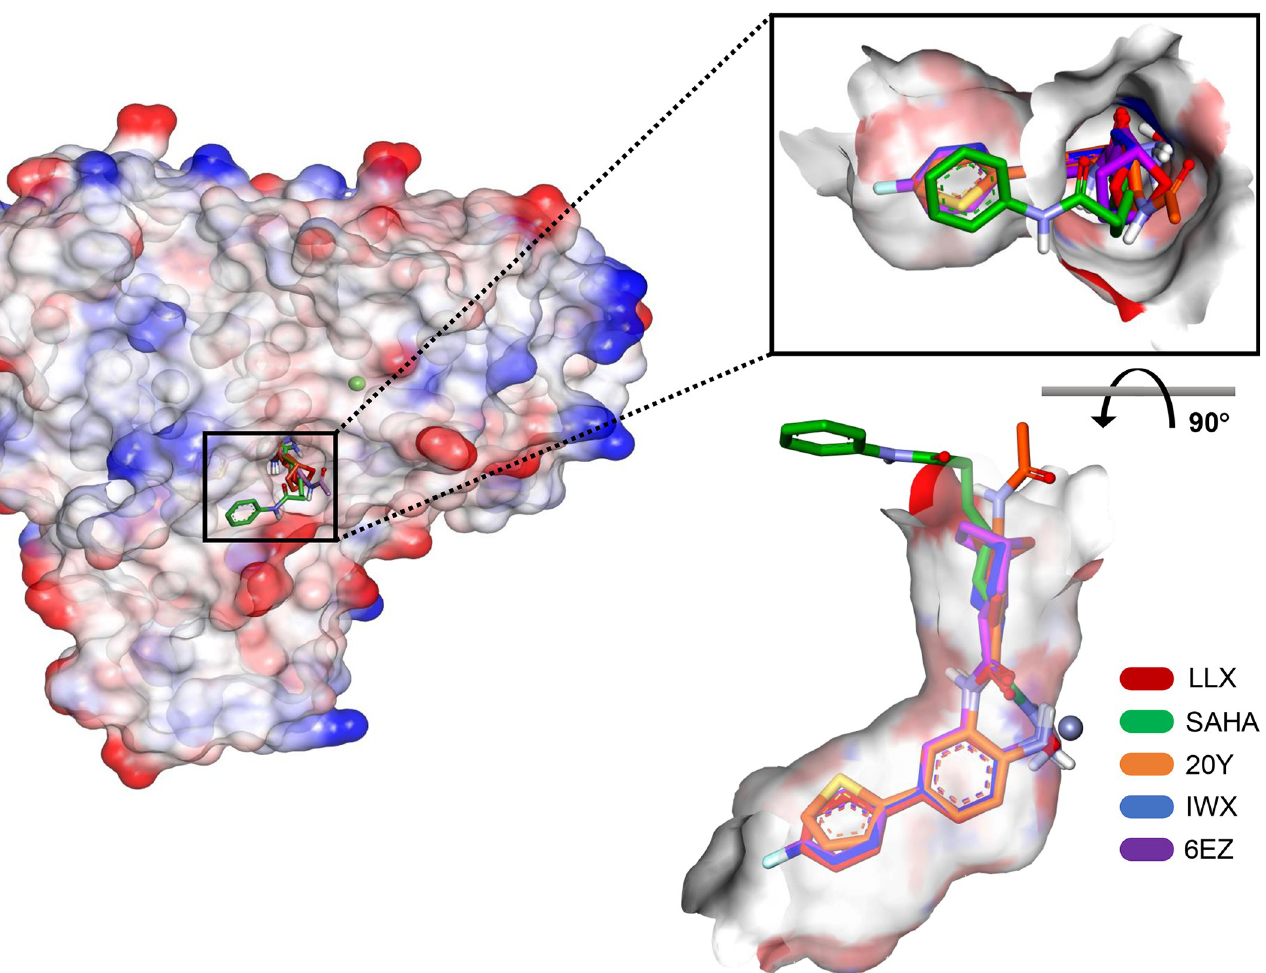
Fig 1. Structural overview of HDAC2 and its active site location. (Left) Electrostatic surface representation of HDAC2 showing the binding location of its inhibitors. (Right) Overlaid structures of inhibitor ligands when bound to the active site. The inhibitor molecules are illustrated in stick representations showing stabilized conformations of LLX (red), SAHA [60], 20Y (orange), IWX (blue), and 6EZ (purple) ligands, which are structurally overlaid using heavy atom coordinates. Zinc ion is shown as a gray ball.